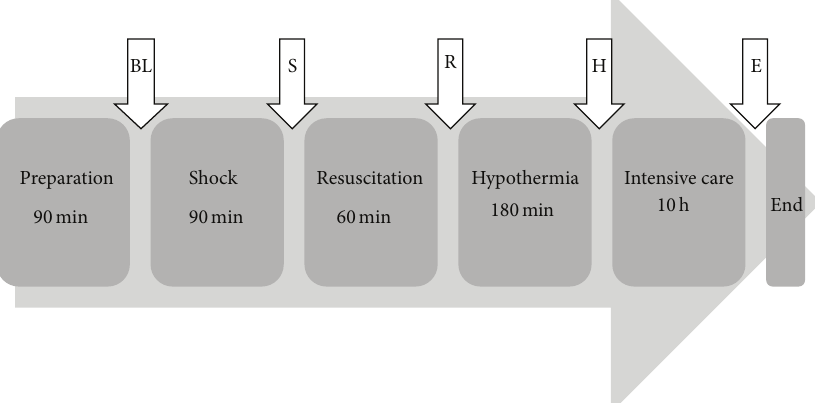
Figure 4: Timeline. The timeline of our porcine polytrauma model is displayed. The measurements were performed at several points of time during protocol: at baseline (BL) straight after 90 minutes of preparation, after 90 minutes of shock (S), after 60 minutes of resuscitation (R), after 180 minutes of therapeutic hypothermia (H), and at the end of protocol (E) (15.5 hours after